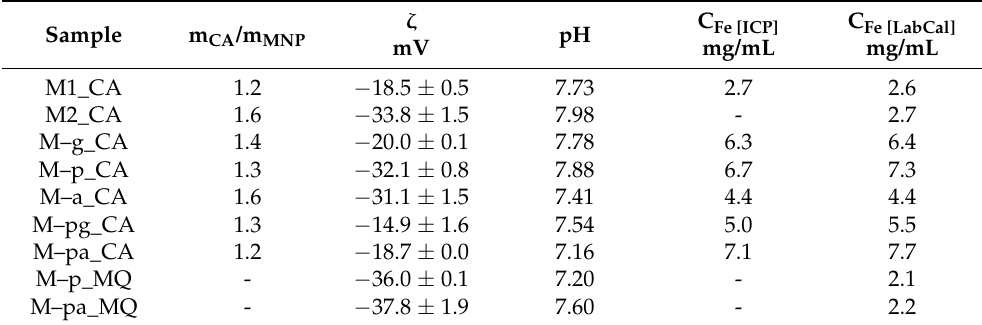
Table 7. Zeta potential, pH, mass ratio of citric acid to MNPs, and total Fe concentration for the _CA ferrofluids and _MQ dispersions.